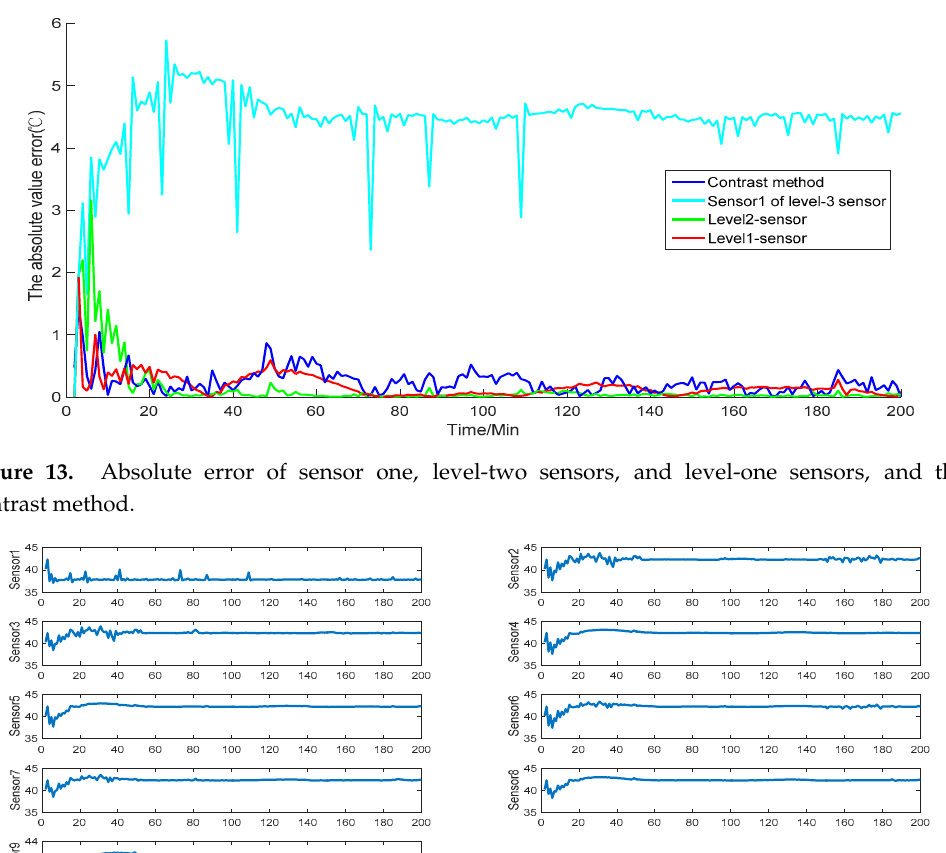
Figure 12. Simulation results of sensor one, level-two sensors, and level-one sensors, and the contrast method.